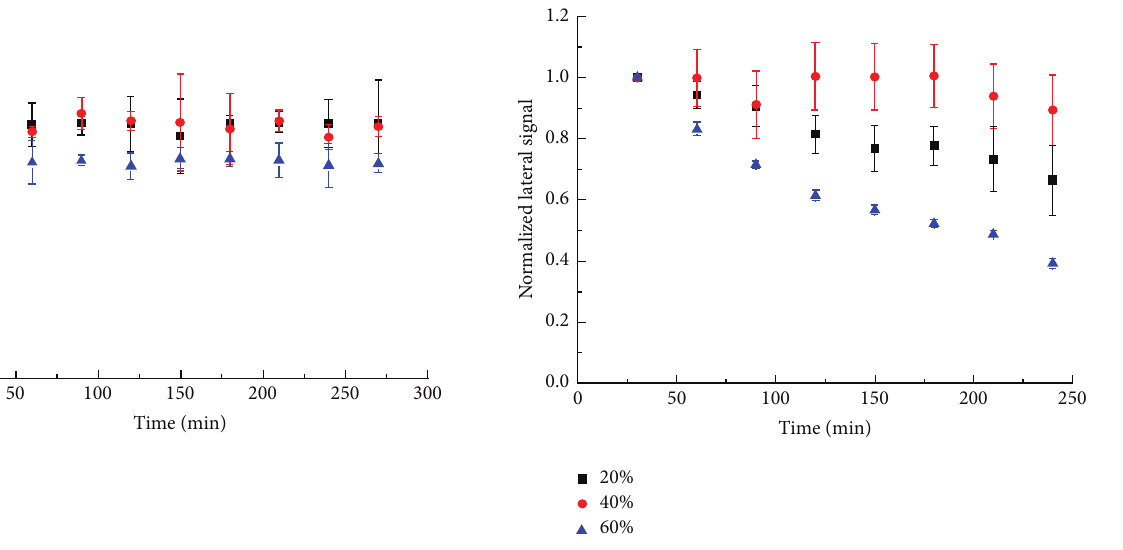
Figure 2: Normalized lateral force signal of MHA at different relative humidity